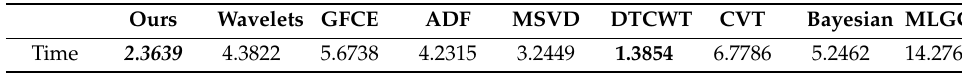
Figure 7. Comparison of the three indicators, MI, CE, and EN on the nato-camp sequences and representative scenes. Different methods are used for comparison. Table 1. Running times of nato with different methods.